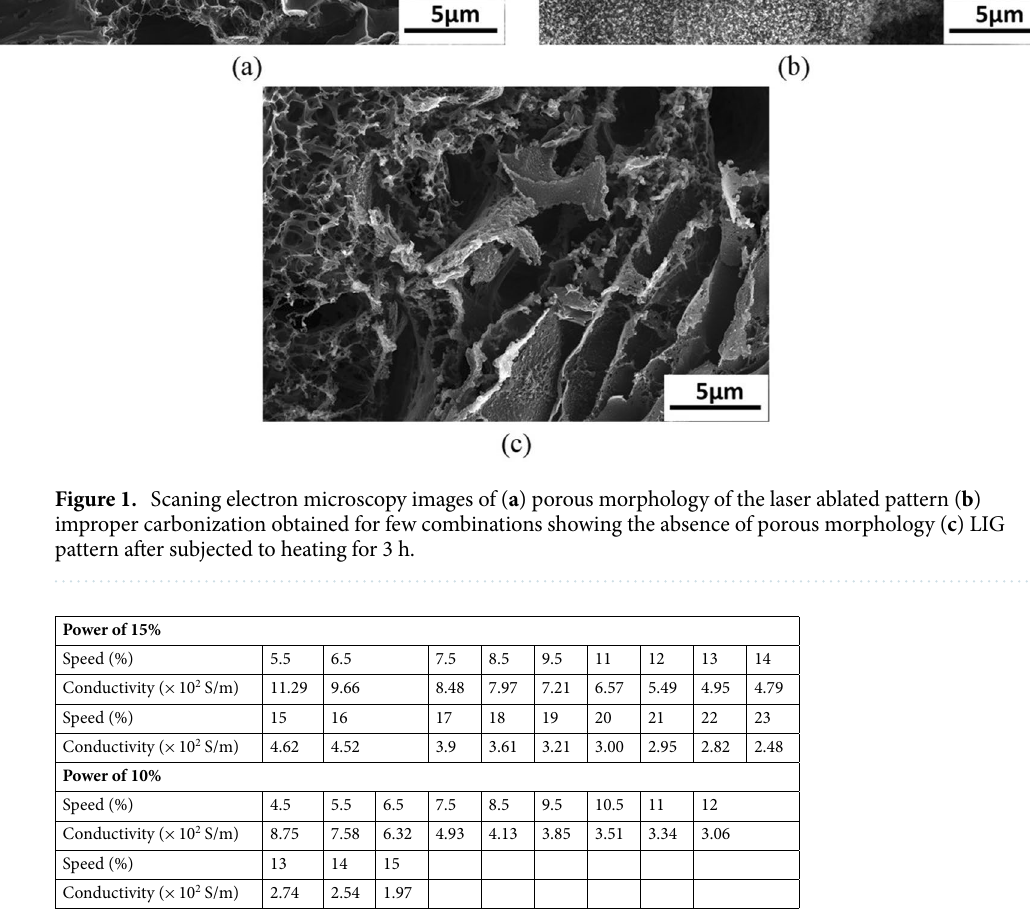
Table 2. Conductivity values of various patterns for the combinations of 15% and 10%